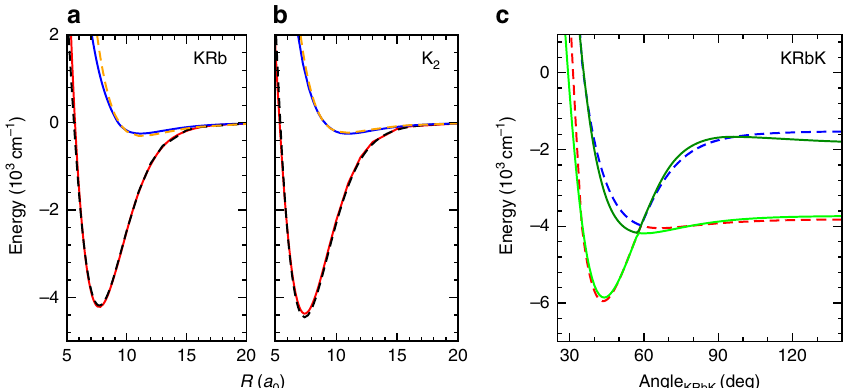
Figure 6 | Dimer and trimer potential energy curves. The calculated singlet X 1 S þ and triplet a 3 S þ potentials of KRb (solid lines in a ) and K 2 (solid lines in b ) as a function of inter-atomic separation using the same basis set and core polarization potential as for the KRbK trimer. The dashed lines in both panels are the corresponding spectroscopically accurate dimer potentials 39,40 . ( c ) A one-dimensional cut through the two energetically lowest adiabatic KRbK trimer potential surfaces based on full (solid lines) and pairwise (dashed lines) calculations for R K(1)Rb ¼ R K(2)Rb ¼ 10 a 0 .